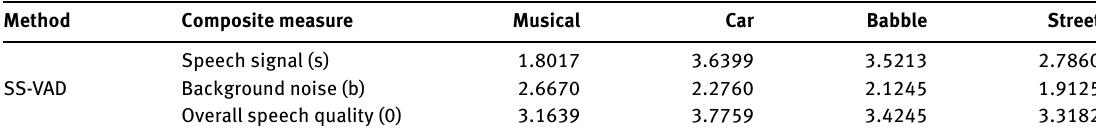
Table 4: Performance Evaluation of SS-VAD Method Using Composite Measure for TIMIT Database. Method